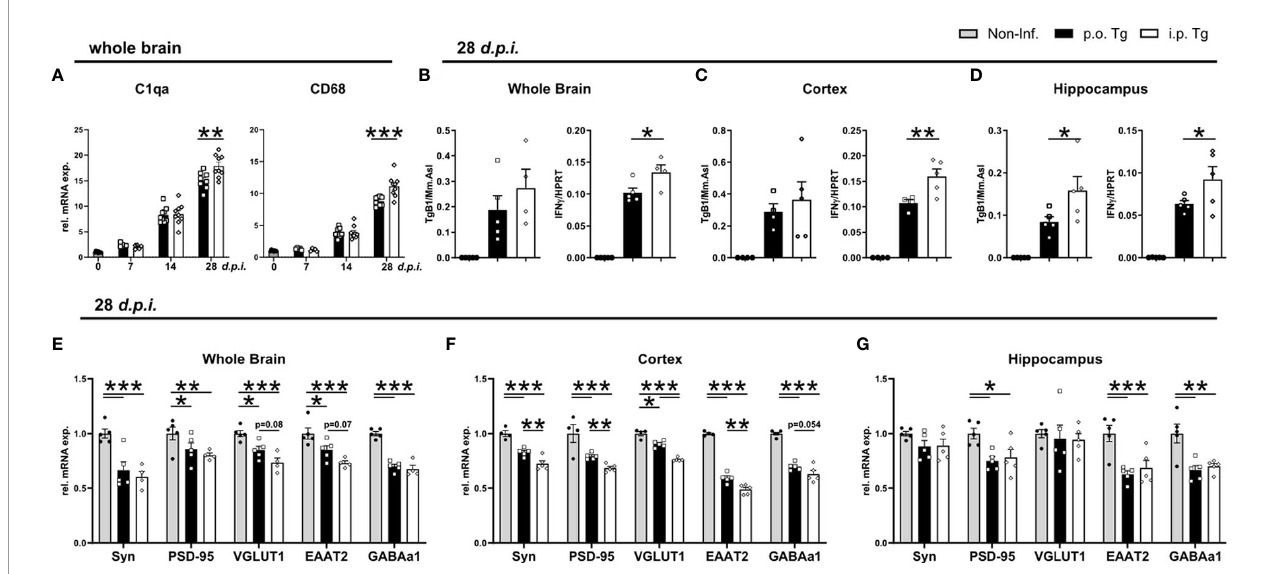
FIGURE 6 | Increased IFN g gene expression and reduction of synapse-associated gene expression in the cortex of i.p. infected mice. Mice were infected p.o. and i.p. with two cysts of T. gondii for 28 days. (A) Relative mRNA levels of synaptic pruning associated genes, C1qa and CD68. (B – D) Parasite burden (TgB1 expression) and IFN g levels in the whole brain, cortex, and hippocampus of p.o. and i.p. infected animals. Expression of TgB1 gene normalized to the reference gene Mm. Asl. mRNA levels were normalized to the reference gene HPRT. Gene expression in naïve (Non-Inf.), p.o. ( p.o. Tg) and i.p. infected ( i.p. Tg) mice in the early chronic phase (28 d.p.i.) shown for synaptic genes in (E) whole brain, (F) cortex, and (G) hippocampus. Relative gene expression assessed by RT-qPCR analysis. Expression of target genes was normalized to the expression of the reference gene HPRT and subsequently normalized to the mean of naïve mice. Symbols represent individual animals; columns represent means and error bars represent + SEM. A two-way ANOVA followed by Tukey ’ s correction for multiple comparisons (*p<0.05, **p<0.01,